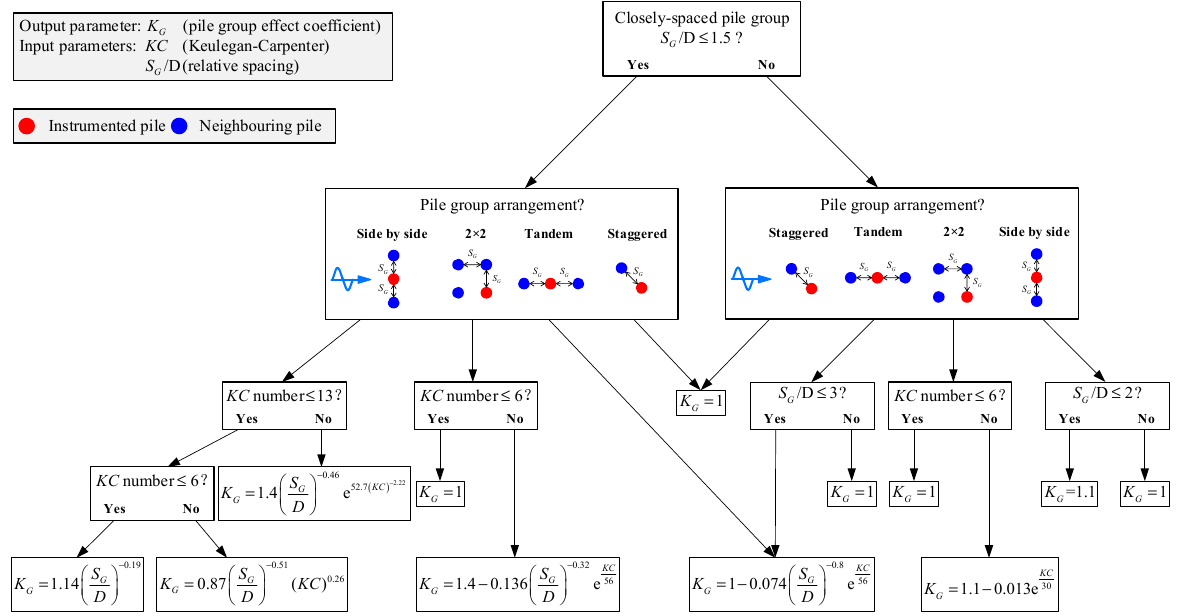
Figure 14. Pile group effect coefficients for different pile group arrangements (reproduced from Bo- nakdar et al. (2015) [138]).